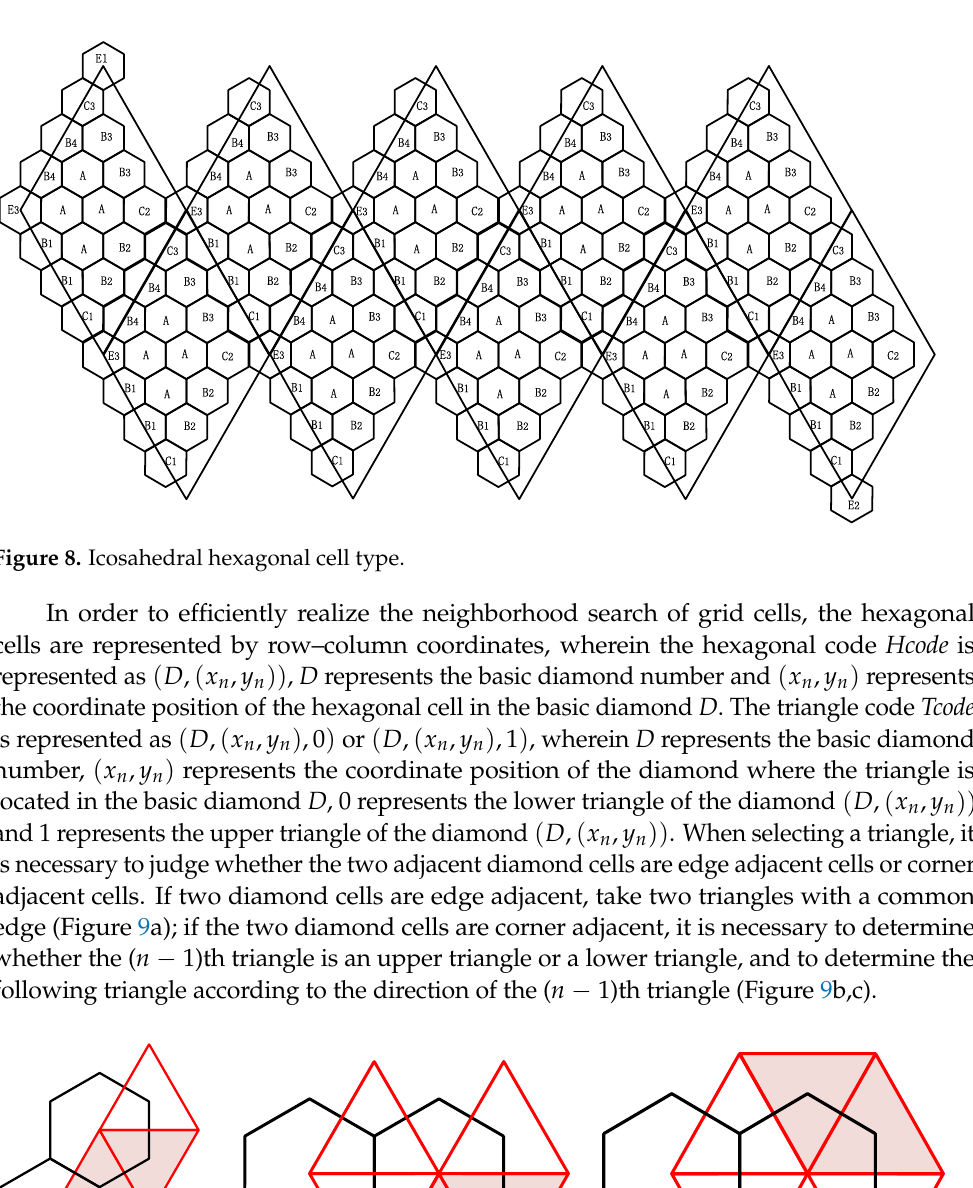
Figure 9. Triangle selection rules of HtoTcode for spatial discrete line and surface data. ( a ) Edge adjacency; ( b ) Corner adjacency and the ( n − 1)th triangle is a lower triangle; and ( c ) Corner adjacency and the ( n − 1)th triangle is an upper triangle.